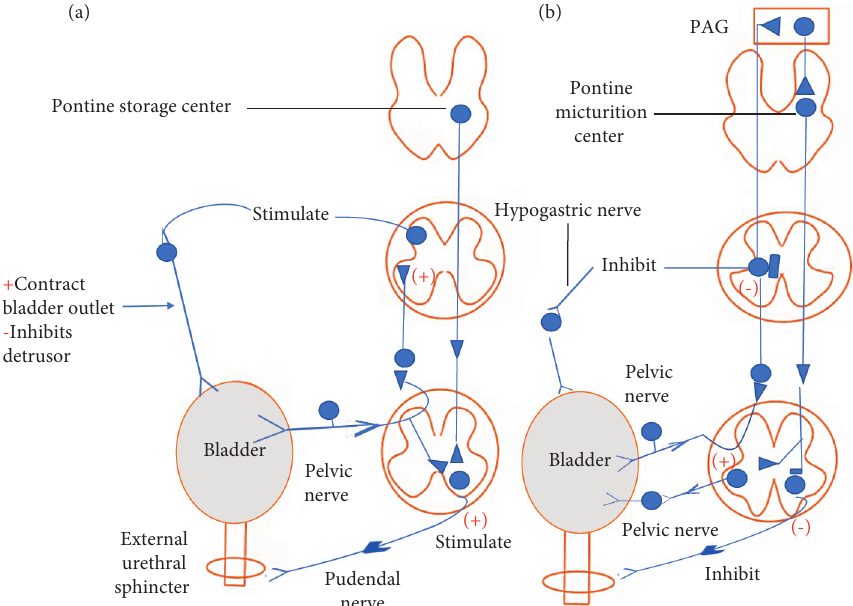
Figure 1: The brain networks that regulate continence and micturition are depicted. Urine storage reflexes. (a). Urine storage reflexes. (b). Urination (or voiding) reflexes the pontine micturition center